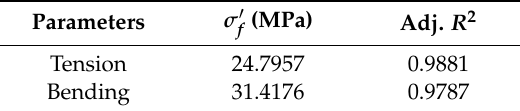
Table 2. The value of fitting parameter of